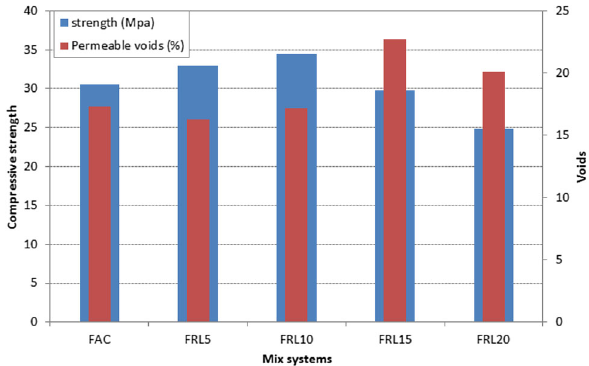
Fig. 3 Strength and permeable voids of various mix systems.